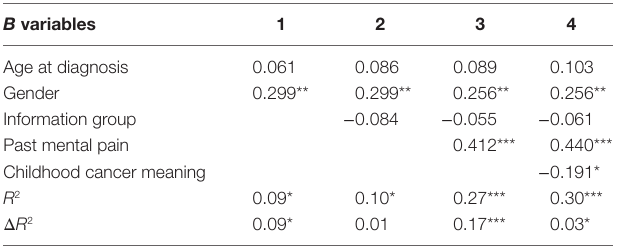
TaBle 4 | hierarchical regression analysis to explain variance of present mental pain ( N =